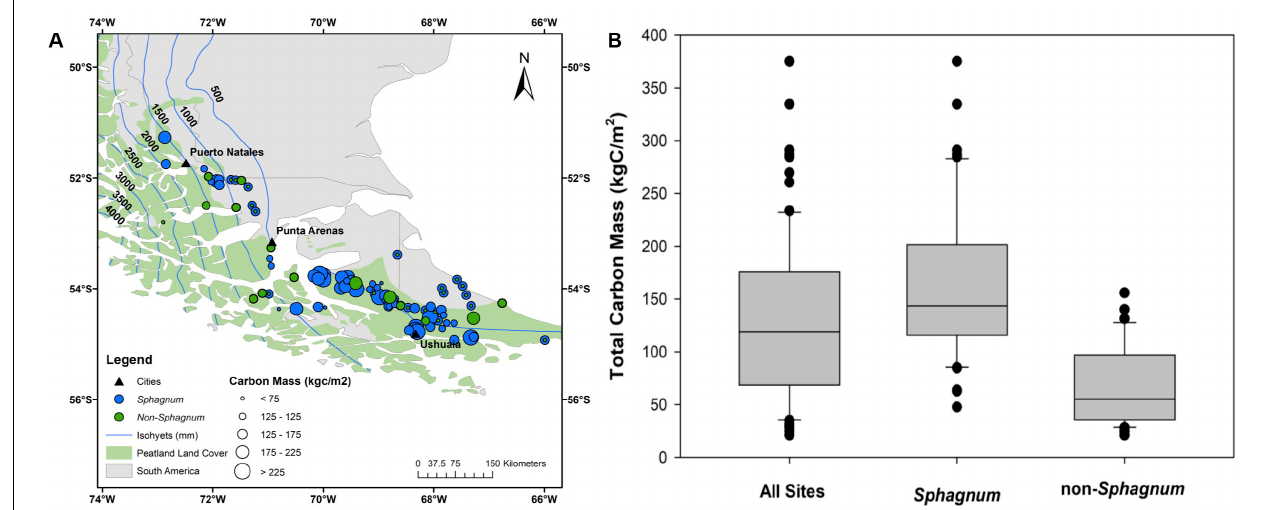
FIGURE 8 | A comparative analysis of Sphagnum vs. non- Sphagnum peat carbon mass per unit area (also referred to as soil carbon density in the text). (A) Spatial distribution of Sphagnum (blue circles) and non- Sphagnum (in green) peatlands and associated carbon mass (circle size). (B) Statistical representation of carbon mass for Sphagnum and non- Sphagnum peat types compared to all sites combined. The peatland area is from Yu et al. (2010) and the dataset used to generate the isohyets is from New et al.